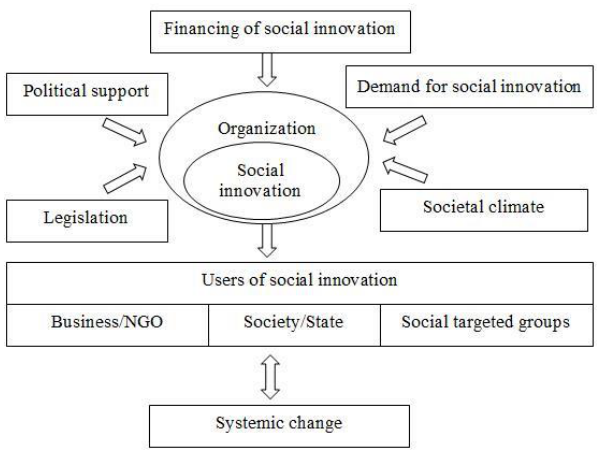
Fig. 1. Interaction of social innovation at an organisation’s